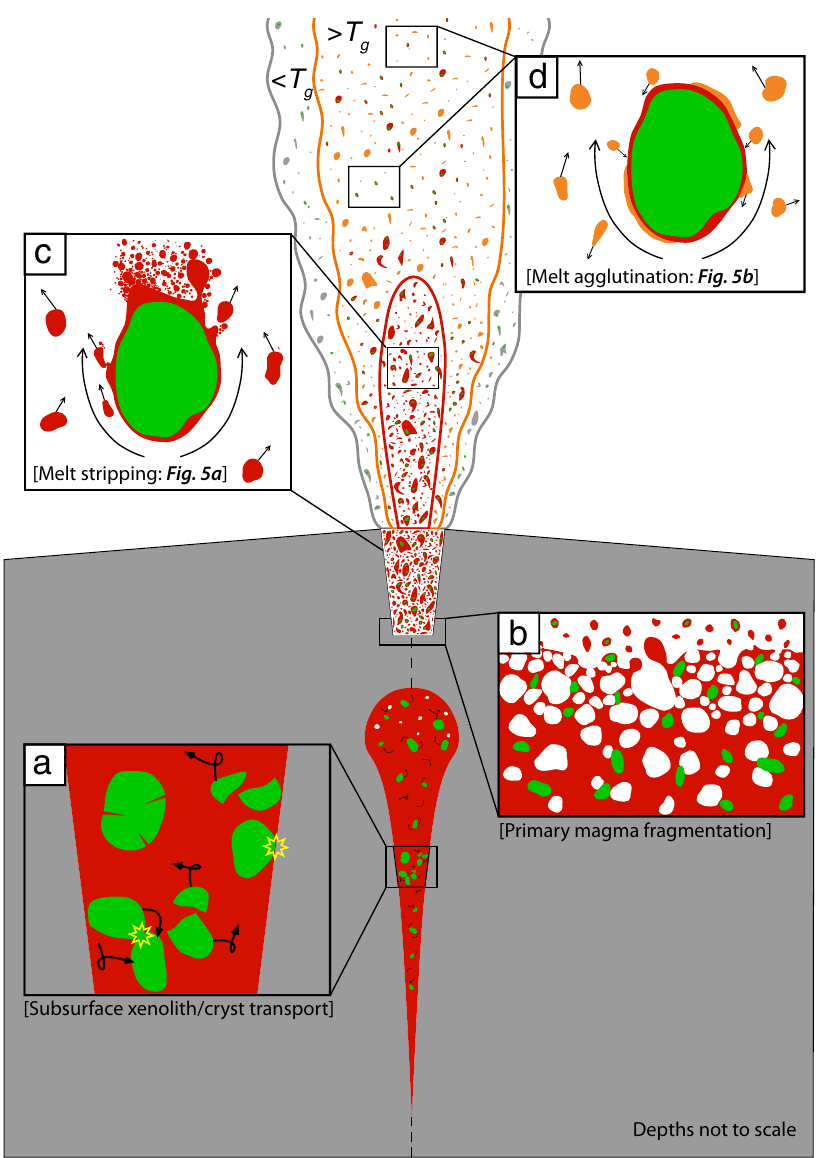
Fig. 4 The key dynamic processes that lead to the pyroclast textures observed. The colour scheme is the same as previous fi gures where, green represents olivine crystals, red represents the homogenous melt and orange represents the complex melt. Gas is shown in white, and the grey at the fountain/jet edge indicates the cooler portion of the fountain/jet that is below the glass transition temperature, T g . a Within conduit/dyke mechanical abrasion of olivine crystal cargo. b A simple depiction of the primary magma disruption and formation of melt-coated crystals and melt droplets at the free surface. We note that these primary fragmentation processes are likely to be highly variable and complex. c Stripping of the mobile, high-temperature melt from crystal surfaces (see Fig. 5a) and d in the lower velocity part of the fountain, in- fl ight particle agglutination (see Fig. 5b). Note that agglutination processes shown in d can also occur in the subsurface when velocities are reduced due to conduit widening, for